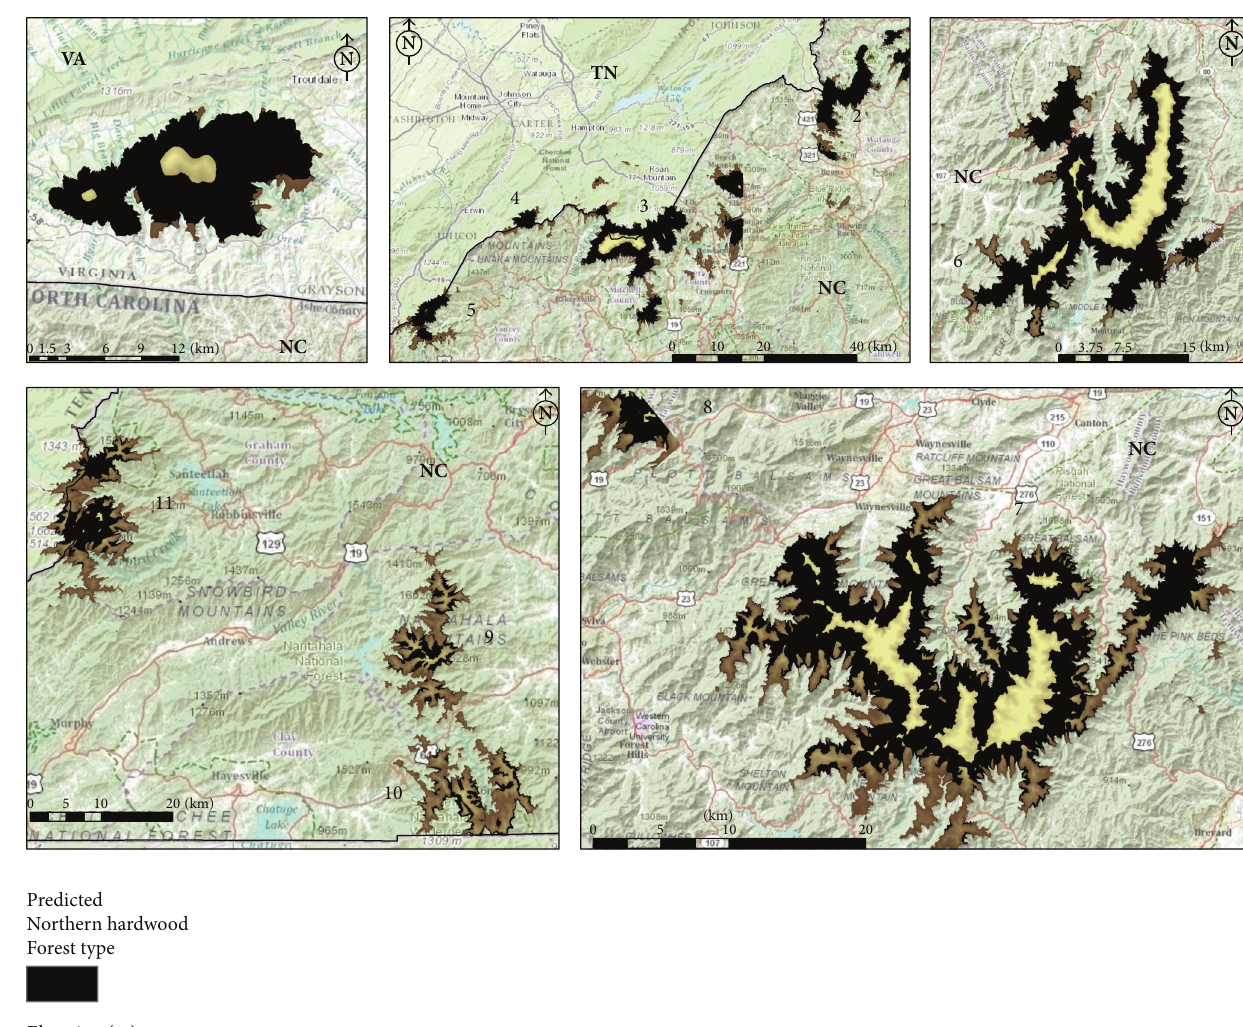
Figure 2: Predictive map for the study area created using the elevation + TEI model showing predicted northern hardwood forest type that was surveyed in June 2012–January 2013. Areas are numbered to correspond with map in Figure